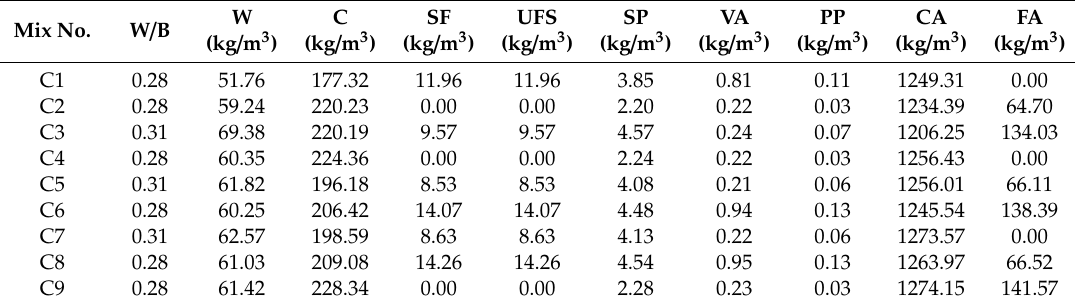
Table 7. Mix proportions of pervious